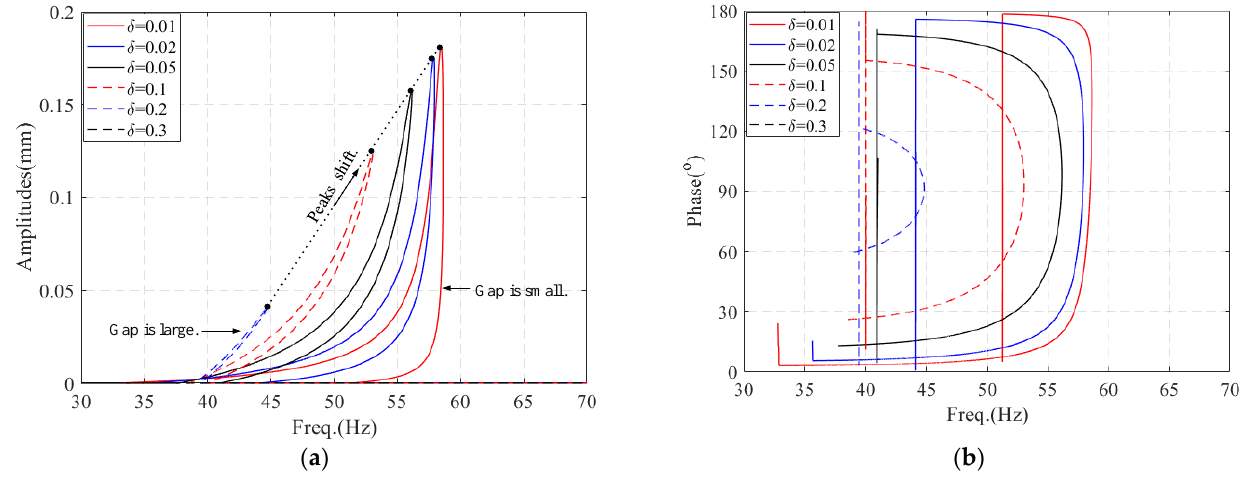
Figure 22. Amplitude – frequency and phase – frequency characteristics of the 3# bearing-support: ( a ) amplitude – frequency characteristics; ( b ) phase – frequency characteristics.